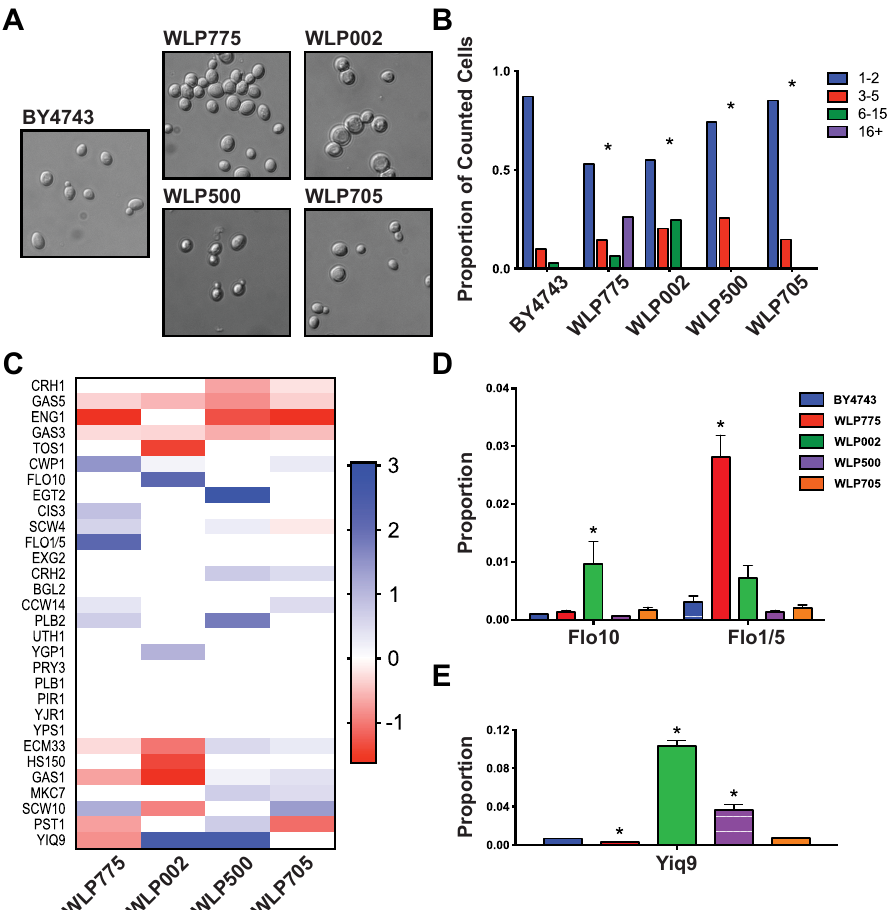
Figure 1. Yeast flocculation and cell wall proteome. ( A ) Microscopy images of the five yeast strains (400x magnification); ( B ) flocculation extent of each strain. * p < 0.01 with comparison to BY4743; ( C ) heat map of significantly differentially abundant proteins ( p < 10 − 5 ) between designated yeast strain and BY4743. Values shown as log 2 (fold change); ( D ) abundance of Flo1/5 and Flo10 in the cell wall; ( E ) abundance of YIQ9 in the cell wall. Values, mean. Error bars, SEM. * p < 10 − 5 with comparison to